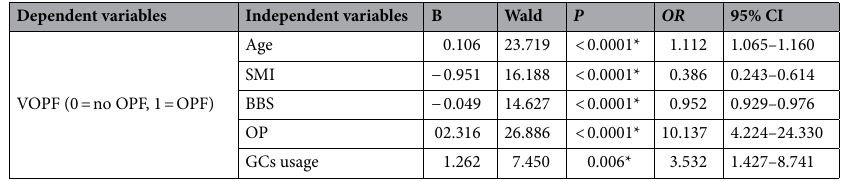
Table 4. Logistic regression analysis of VOPF in female RA. * P value <